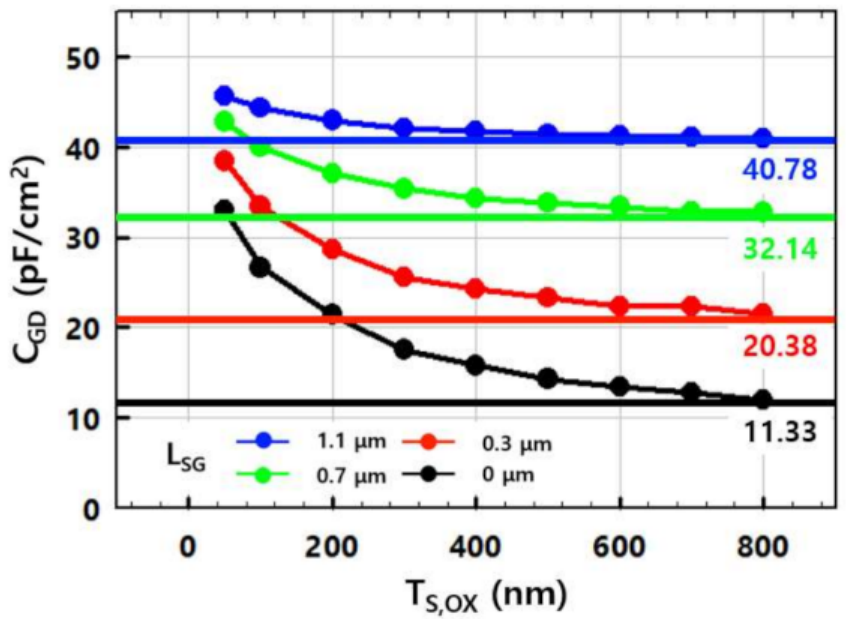
Figure 6. Comparison of C GD (gate-to-drain capacitance) values of SG-DMOSFET (split-gate DMOS- FET) and FPS-DMOSFET (floating p+ polysilicon split-gate DMOSFET) according to L SG (active gate length)